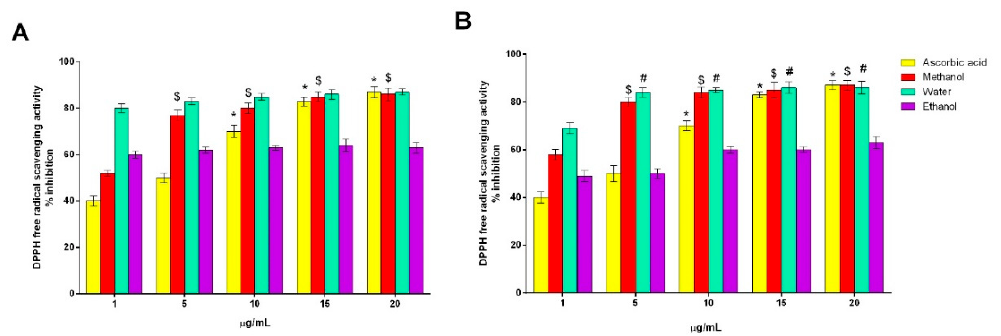
Figure 4. 2,2-diphenyl-1-picrylhydrazyl (DPPH) free-radical-scavenging activity: ( A ) Artocarpus heterophyllus Lam. flower extracts, ( B ) Artocarpus lakoocha Roxb. flower extracts. All measurements were performed in triplicate. Data are shown as the mean ± standard deviation, and one-way ANOVA with a Newman–Keuls post-test was used for statistical significance; * p < 0.05 vs. 1 µ g / mL ascorbic acid; $ p < 0.05 vs. 1 µ g / mL methanol extract; # p < 0.05 vs. 1 µ g / mL water extract.